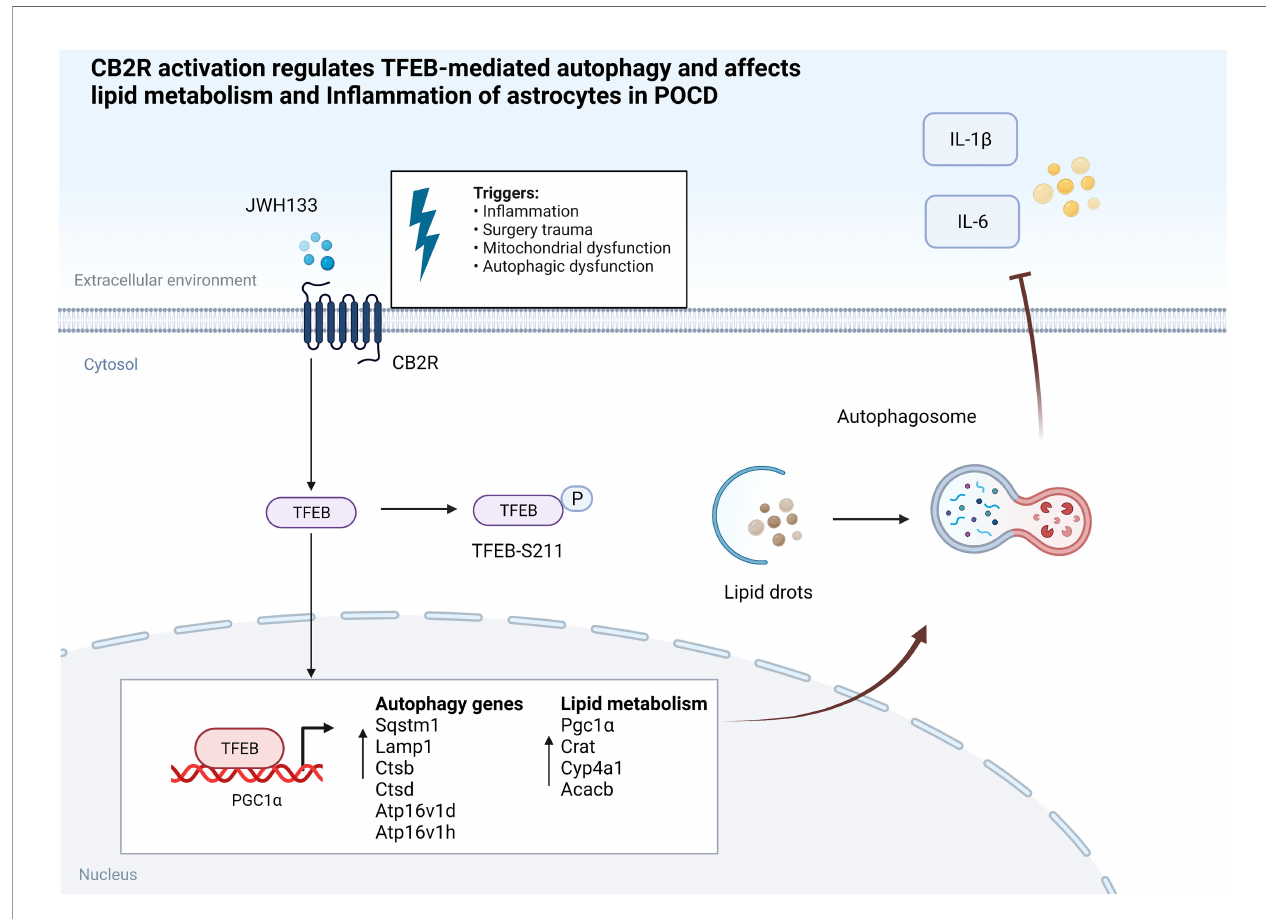
FIGURE 7 | CB2R activation regulates TFEB-mediated autophagy and affects lipid metabolism and in fl ammation of astrocytes in